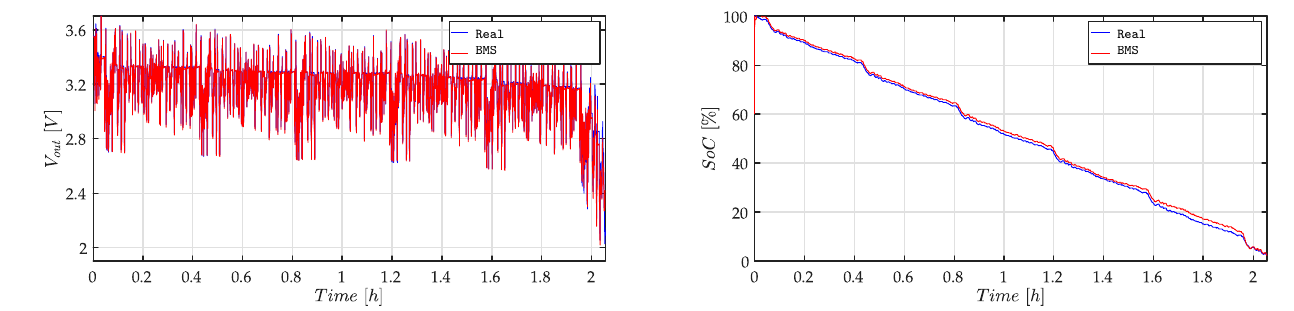
Figure A2. SoC and V out time series referring to the A123-FUDS dataset considering the best PI-ENNC BMS model on the test set.